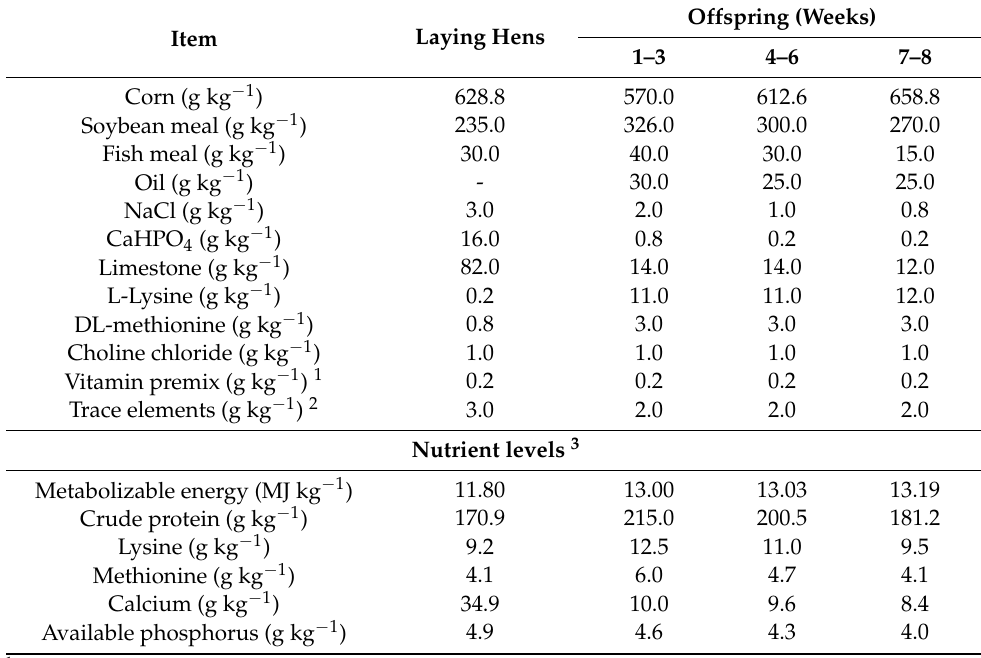
Table 1. Composition and ingredients of the basal diets for laying hens and offspring.